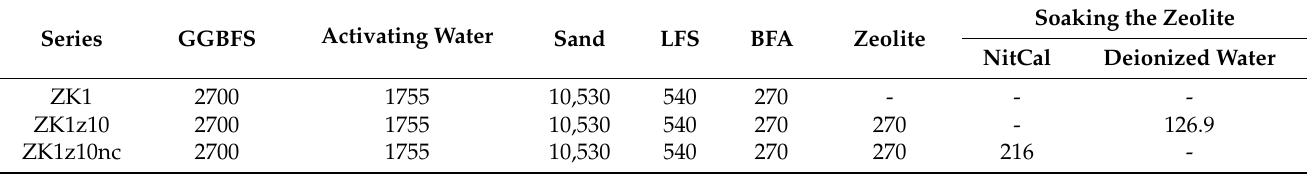
Table 5. Mixes of slag-ash mortars of 3 series, in